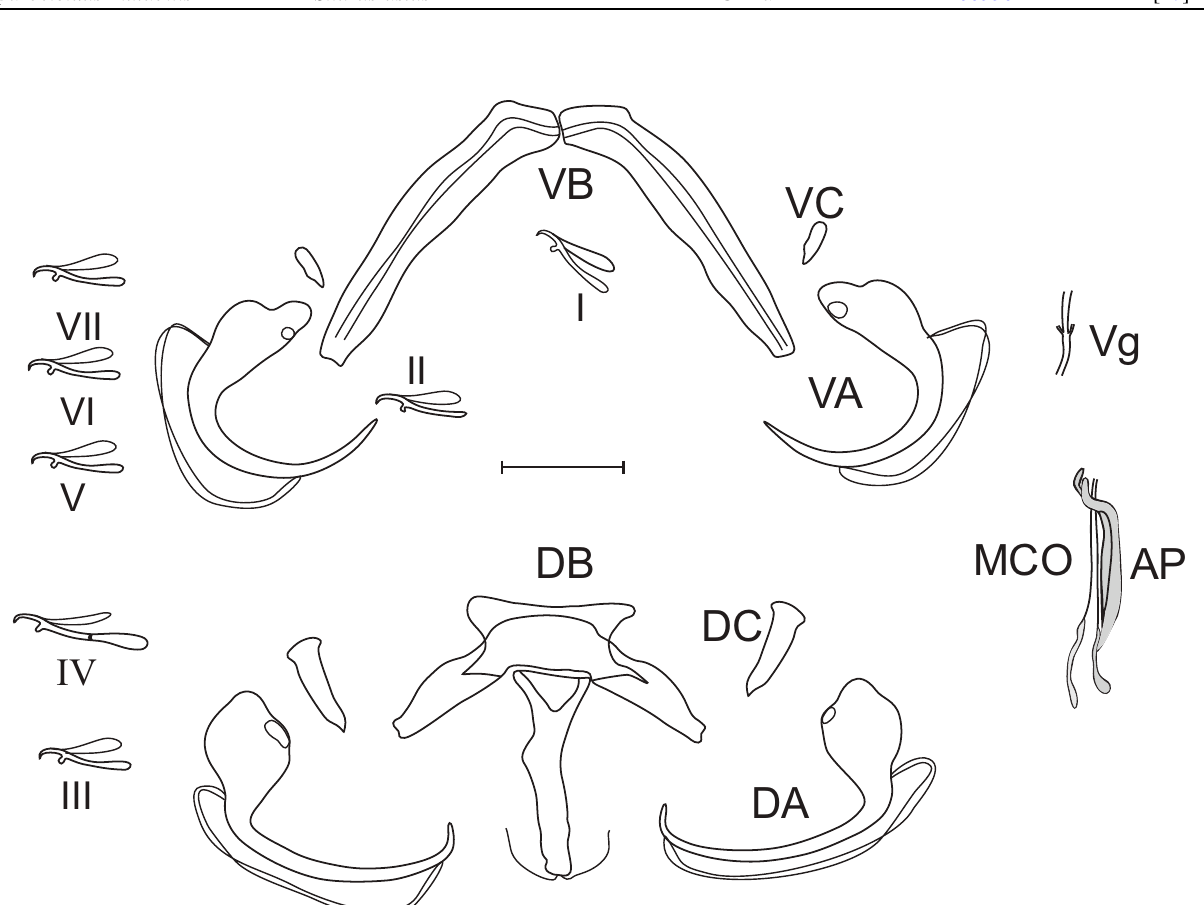
Figure 3. Quadriacanthus levequei Birgi, 1988; (VA) Ventral anchor, (DA) Dorsal anchor, (AP) Accessory piece, (MCO) Male copulatory organ, (DC) Dorsal cuneus, (VC) Ventral cuneus, (DB) Dorsal bar, (VB) Ventral bar, Hooks (I – VII), (Vg) Vagina; scale 20 l